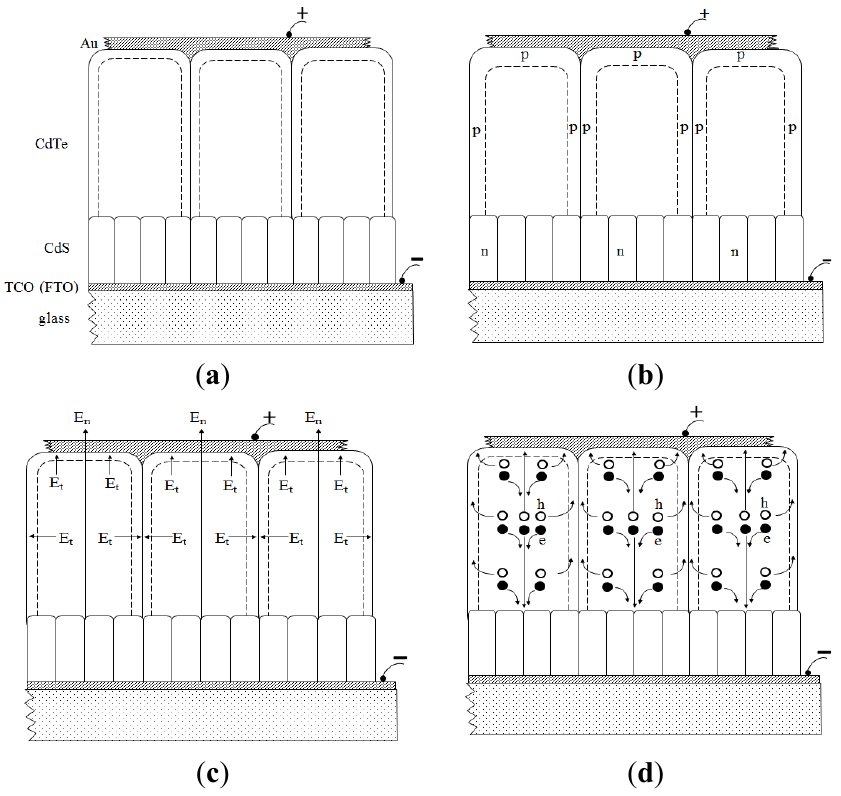
Figure 16. Schematic diagram of ( a ) rod-type CdS/CdTe solar cells; ( b ) doping effects of grains after CdCl 2 treatment; ( c ) presence of local electric fields (E t ) in addition to the main electric field (E n ) within the device; and ( d ) photo-generated charge carrier creation, separation, and collection with high current densities along grain